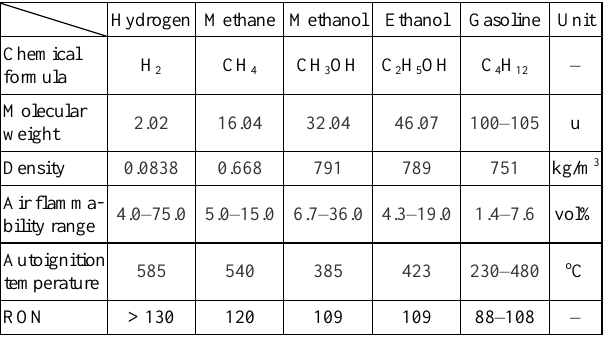
Table 1. Selected parameters of hydrogen and other fuels